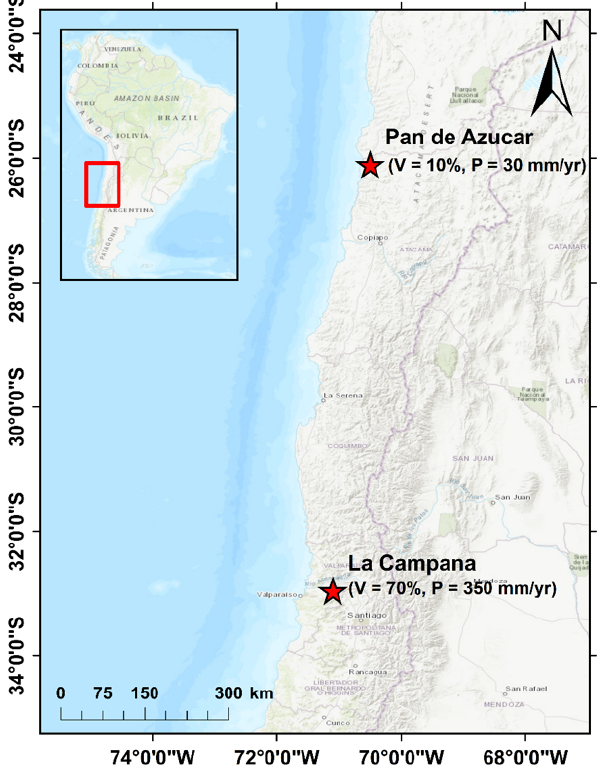
Figure 1. The representative study areas in the Chilean Coastal Cordillera used for the model setup. The model parameters were loosely tuned to the climate and vegetation conditions in these areas (Schmid et al., 2018). The Pan de Azucar area in the north neighbors the Atacama Desert and has sparse vegetation cover (10%) and an arid climate (30mmyr − 1 ). The La Campana area in south has a Mediterranean climate and ecosystem with more abundant vegetation (70%) and precipitation (350mmyr − 1 ). These two study areas are part of the German EarthShape pri- ority research program (https://esdynamics.geo.uni-tuebingen.de/ earthshape/index.php?id=129, last access: 15 January